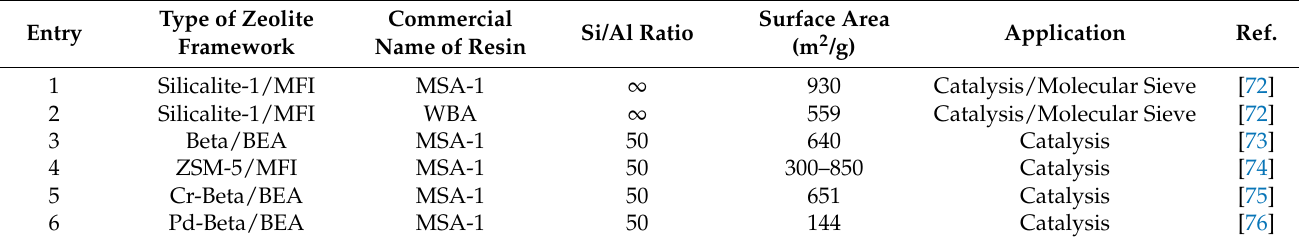
Table 2. Summary of properties of synthesized zeolite beads.